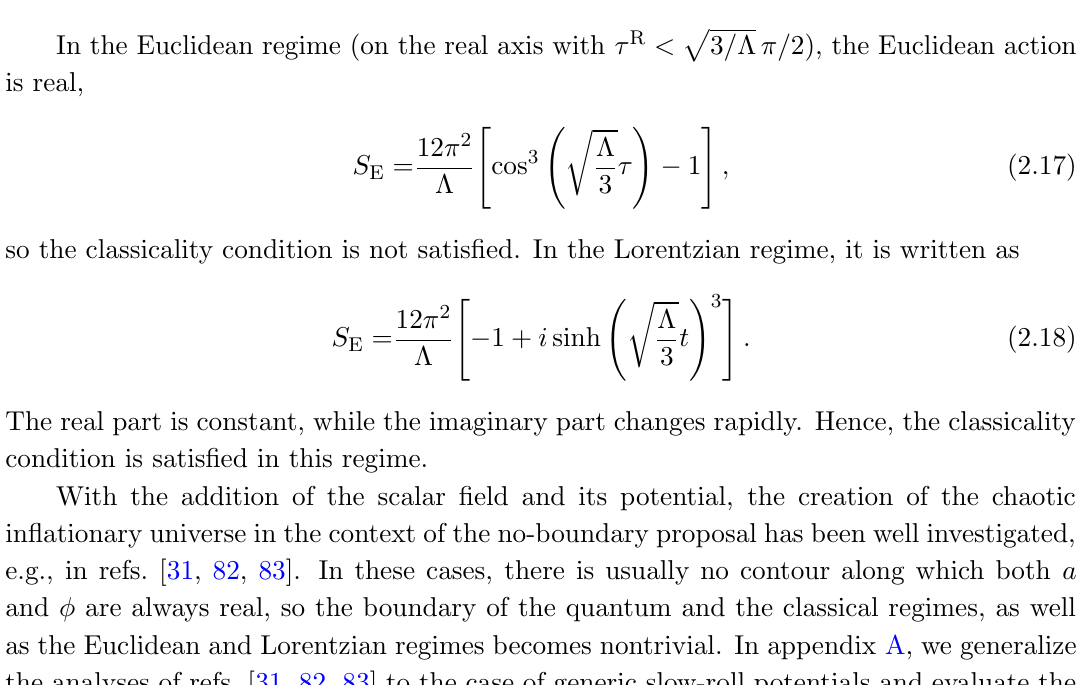
Figure 1. Schematic view of the creation of de Sitter universe from nothing embedded in a higher dimensional (cid:13)at Euclidean spacetime. The half-sphere in the Euclidean part is smoothly connected to the half hyperboloid in the Lorentzian